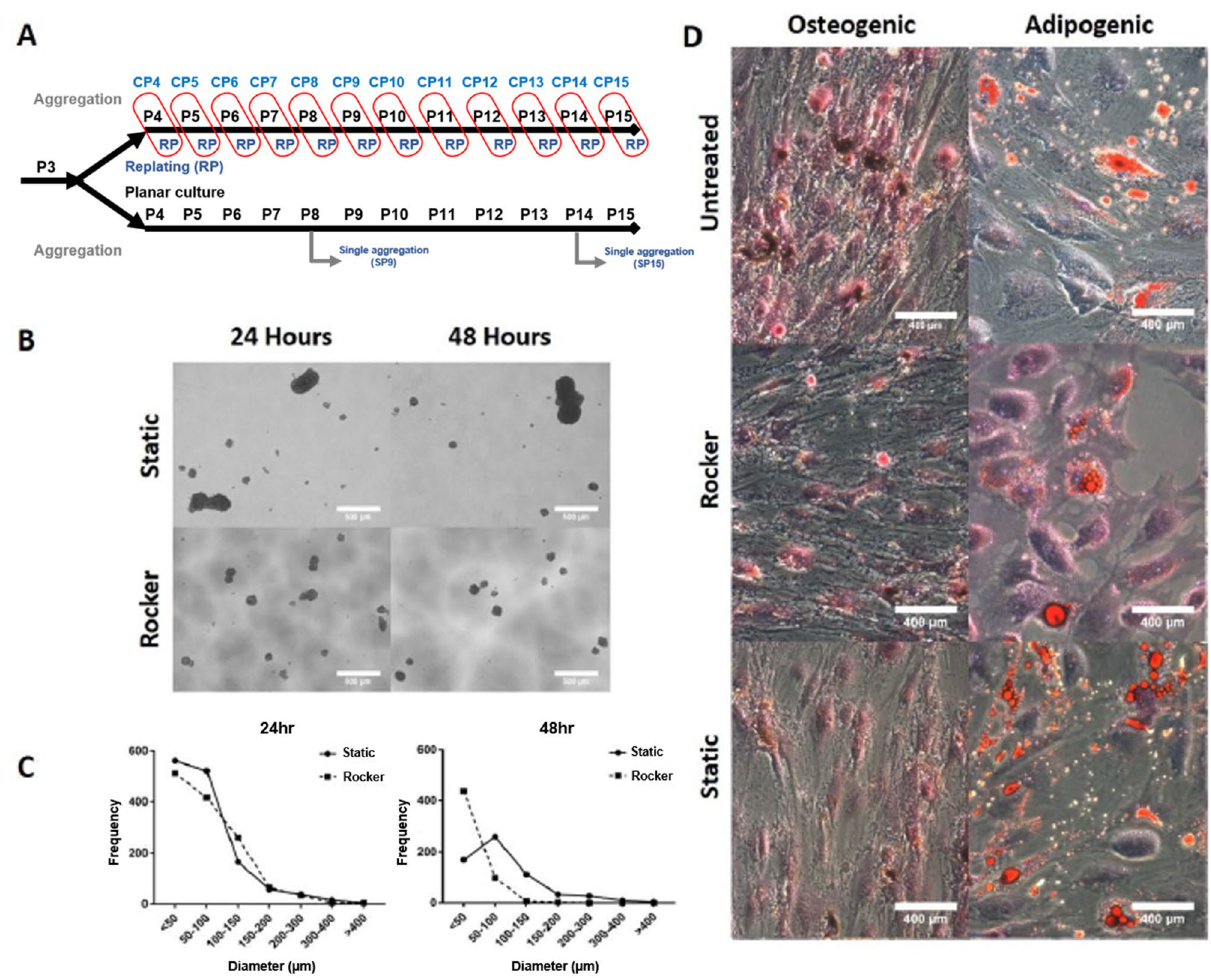
Figure 4. Analysis of static verses dynamic (rocker) aggregate formation in a low-attachment plate. ( A ) Experimental flow: For cyclical aggregation, hASCs were aggregated for two days before being trypsinized and replated until they reach confluence. For planar culture and single aggregation experiment, hASCs were cultured on tissue culture treated surfaces. ( B ) Microscopic images of aggregates formed under static and rocker-based aggregation culture at 24 and 48 h post-seeding. ( C ) Histogram of aggregate diameters for 24 and 48 h for both static and rocker-based aggregation. ( D ) Osteogenic and adipogenic differentiation potential following aggregation under static culture or rocker-based aggregation culture compared with untreated (non-aggregated)